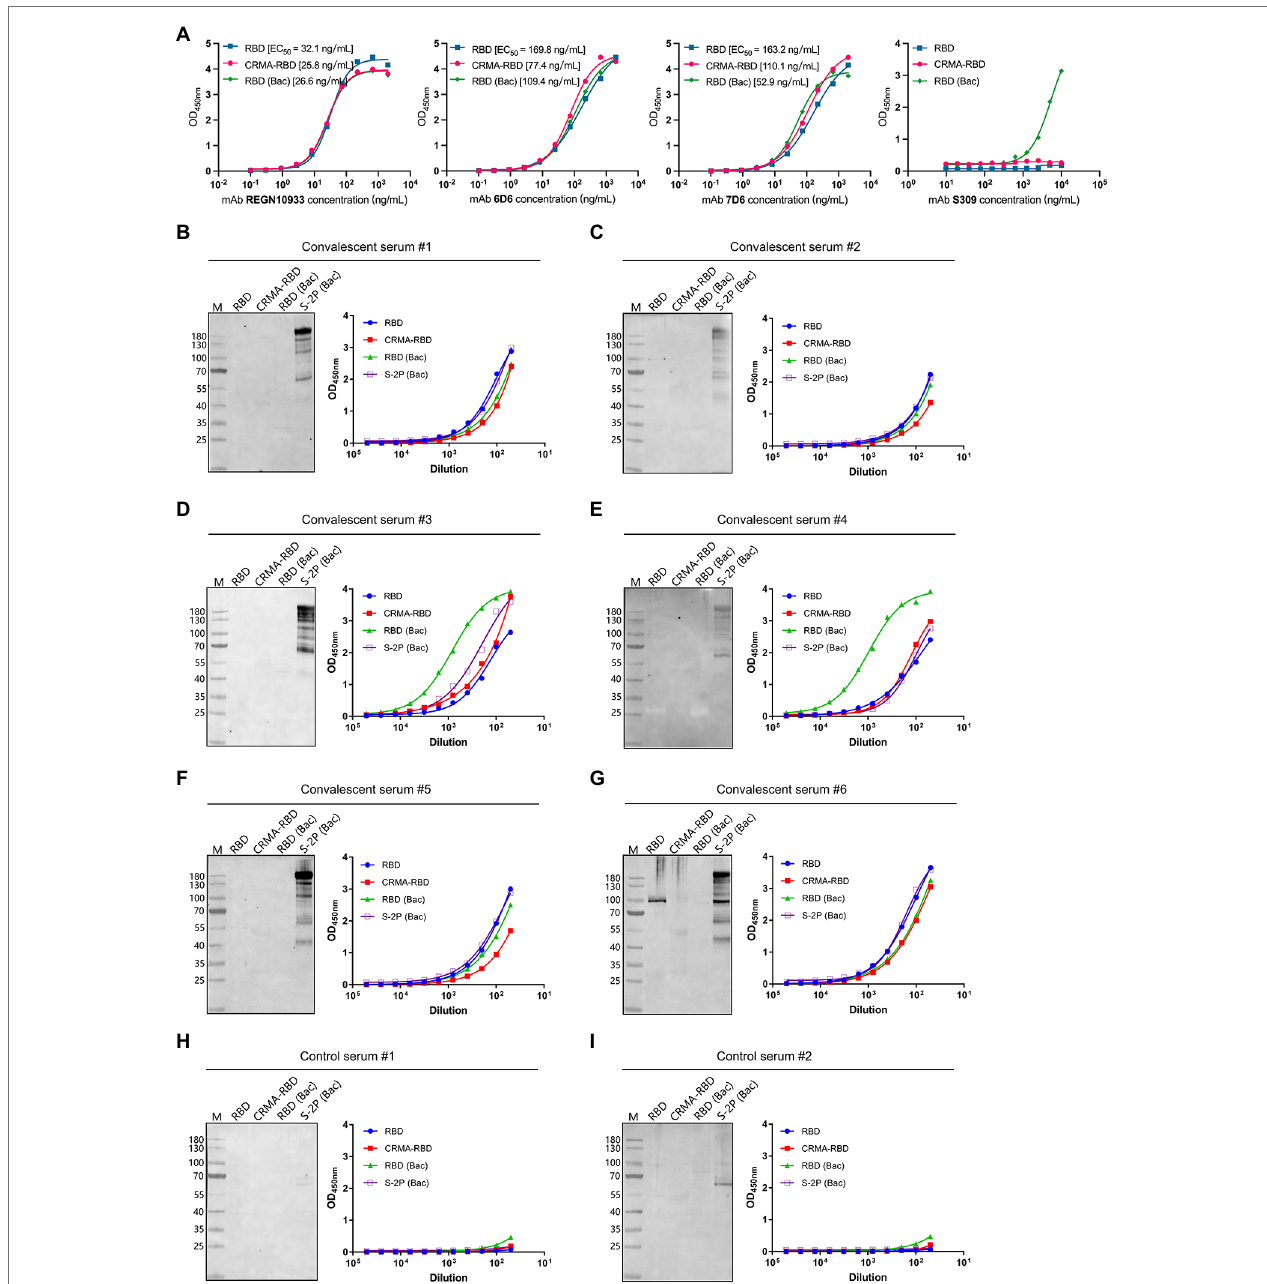
FIGURE 2 | Antigenicity of the CRMA-RBD and RBD proteins against SARS-CoV-2 neutralizing antibodies (nAbs) and Coronavirus disease 2019 (COVID-19) convalescent sera. (A) The reactivity of the CRMA-RBD, RBD, and RBD (Bac) proteins with four nAbs (REGN10933, 6D6, 7D6, and S309) determined by ELISA. (B–G) The reactivity of the CRMA-RBD, RBD, RBD (Bac) and S-2P (Bac) proteins against the COVID-19 convalescent human sera (#1–#6) as determined using western blotting (left panel) and ELISA (right panel). Convalescent sera were collected from patients with COVID-19 after they had recovered from the disease. (H,I) Results of two control sera collected from non-infected